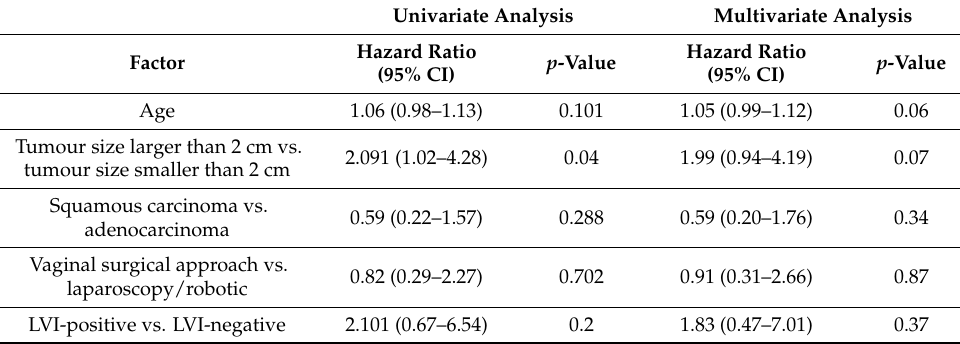
Table 4. Factors associated with disease-free survival (balanced